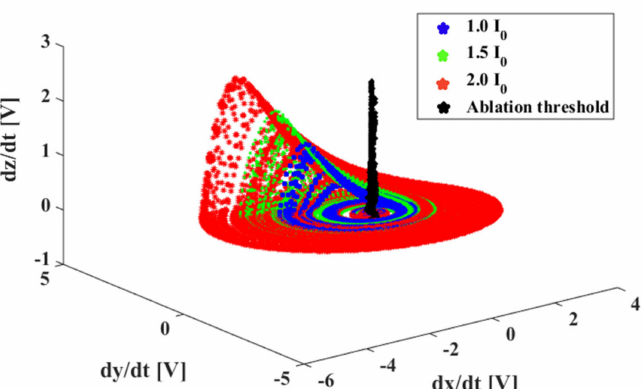
Figure 9. Typical experimental data obtained by chaotic modulation in conductivity measurements. The data in black show a plot with instable behavior, due to the ablation threshold reached in the osteoblast cells during optical irradiation by nanosecond pulses at 532 nm wavelength. Similar results were obtained for the Raji cells, marking the importance of the absorbance of the samples for reproducibility of the